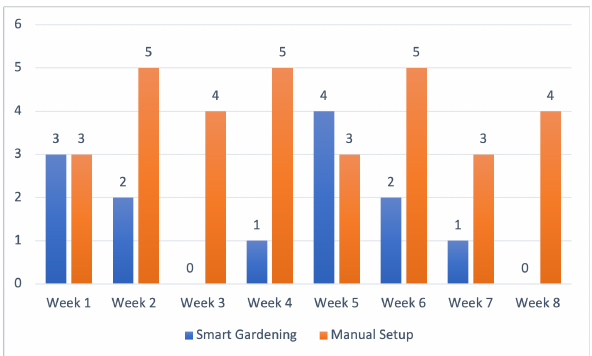
Figure 4. Plot of no. of manual intervention required for smart gardening vs the manual